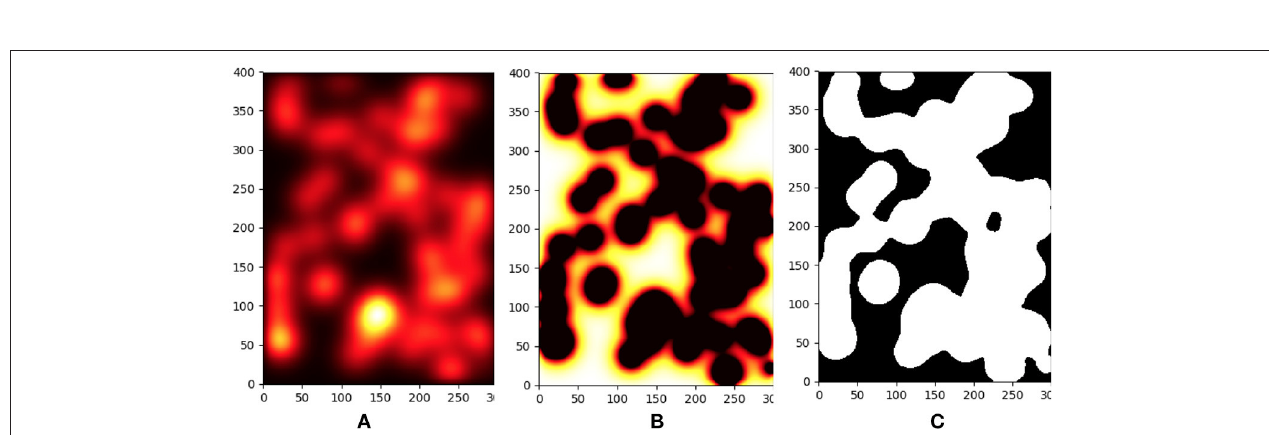
FIGURE 3 | Progression of parenchyma destruction in Agent Based Model. From left to right we see the effect of increased inflammation, tissue damage and final destruction. (A) Concentration of proteases in a small sample of the tissue during model execution. (B) Due to the continued effect of the high proteases levels the tissue is damaged. (C) Snapshot of the damaged tissue as sent to the FEM model. Tissue in foreground (white) has greatly diminished mechanical properties.